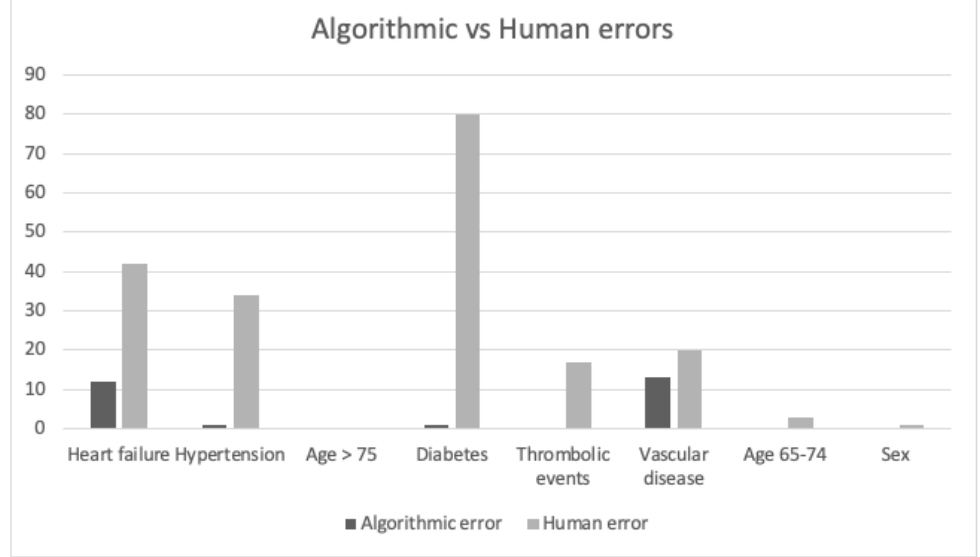
Figure 4. Algorithmic vs. Human errors. Algorithmic error: items aCDSS missed. Human error: items physicians missed (mCDSS). Heart failure: 12 algorithmic errors, 42 human errors. Hyperten-